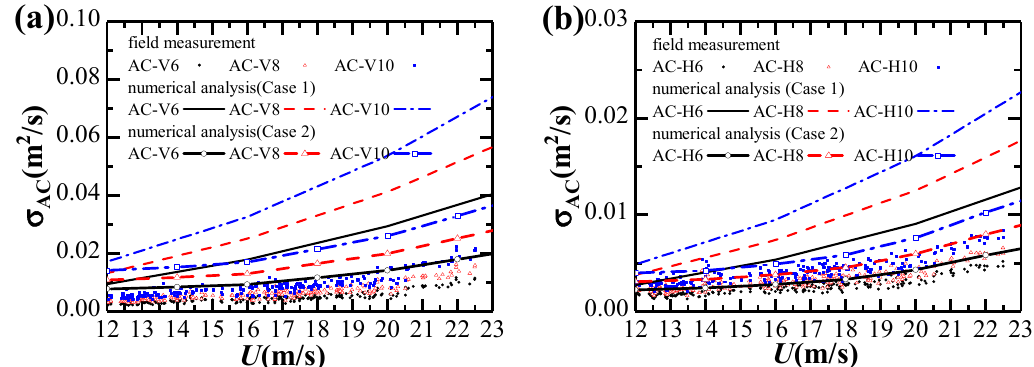
Figure 13. Comparison of standard deviations of acceleration response obtained by field measurements and numerical analysis in Case 1 and Case 2: ( a ) Vertical; ( b ) Horizontal.